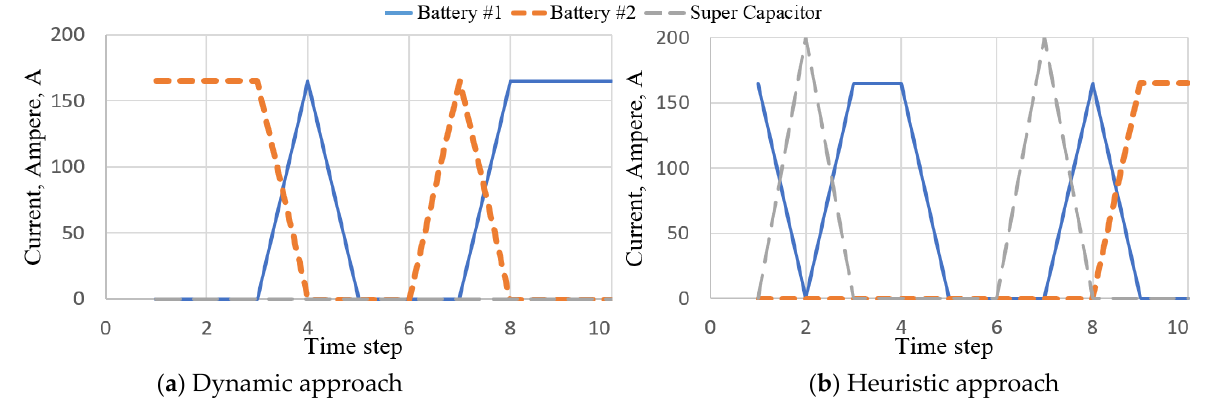
Figure 3. System currents.